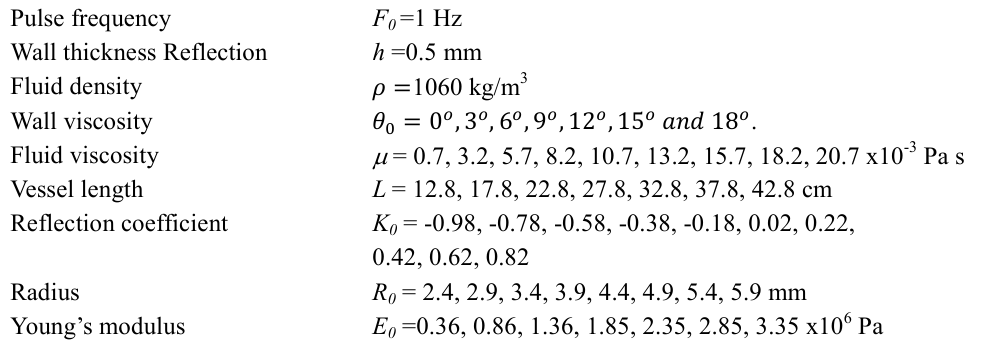
Table 1 values tube parameters and distal termination used in the simulation Pulse